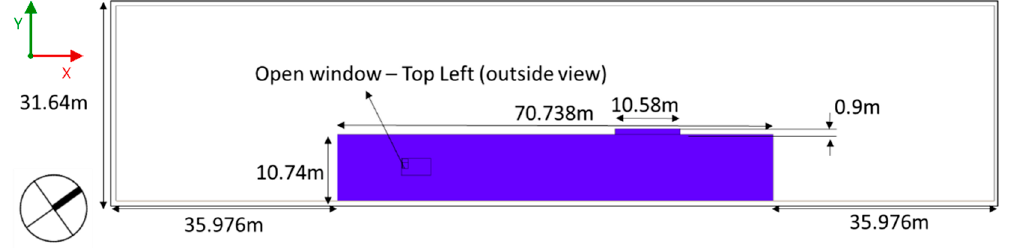
Figure 2. Computational domain.